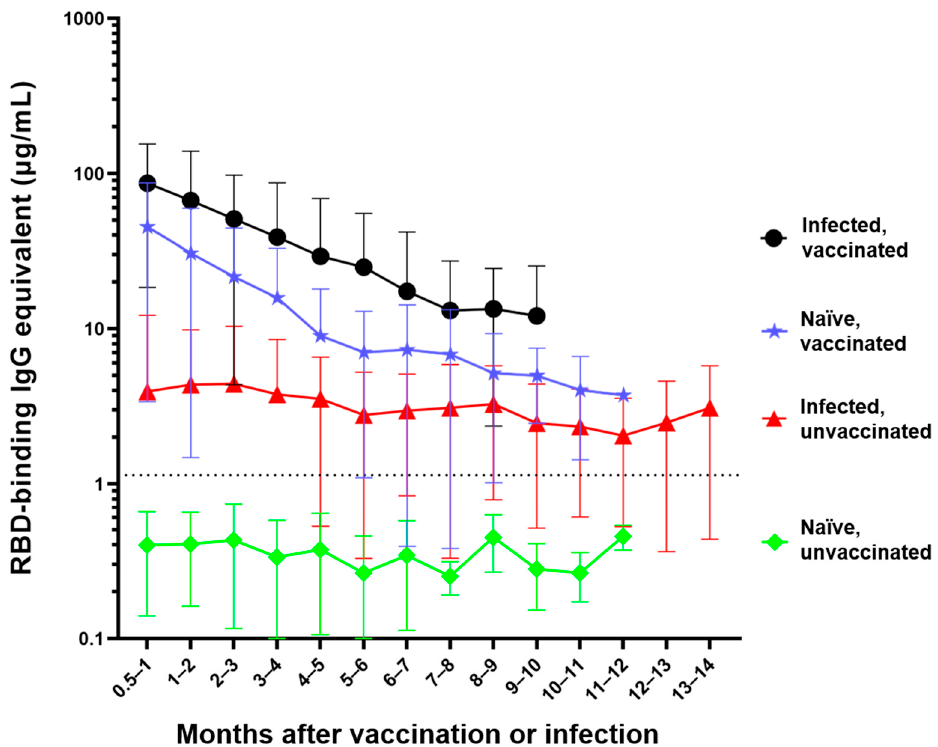
Figure 1. Differential waning of RBD-binding IgG antibody levels based on vaccination and infection status. Naïve unvaccinated (n = 418) and infected unvaccinated (n = 290) show no change in antibody levels over time ( p > 0.05); naïve, vaccinated participants (n = 515) and infected, vaccinated participants (n = 298) both show significant waning over the time (**** p < 0.0001). The antibody level of the naïve unvaccinated group was always lower than the other groups (**** p < 0.0001); the infected vaccinated group was always higher than any other group (** p < 0.0042); naïve, vaccinated group is higher than infected, unvaccinated group for the first 4 months after vaccination (** p < 0.0016). The rate of decay was only significantly different between the vaccinated and infected groups (**** p < 0.0001) but not between the two vaccinated ( p = 0.7914) and the two unvaccinated groups ( p = 0.9569). Number of months start with the time of reception of the primary vaccine series for the vaccinated groups, time of infection for the infected unvaccinated group, and the first available timepoint for the naïve unvaccinated group.